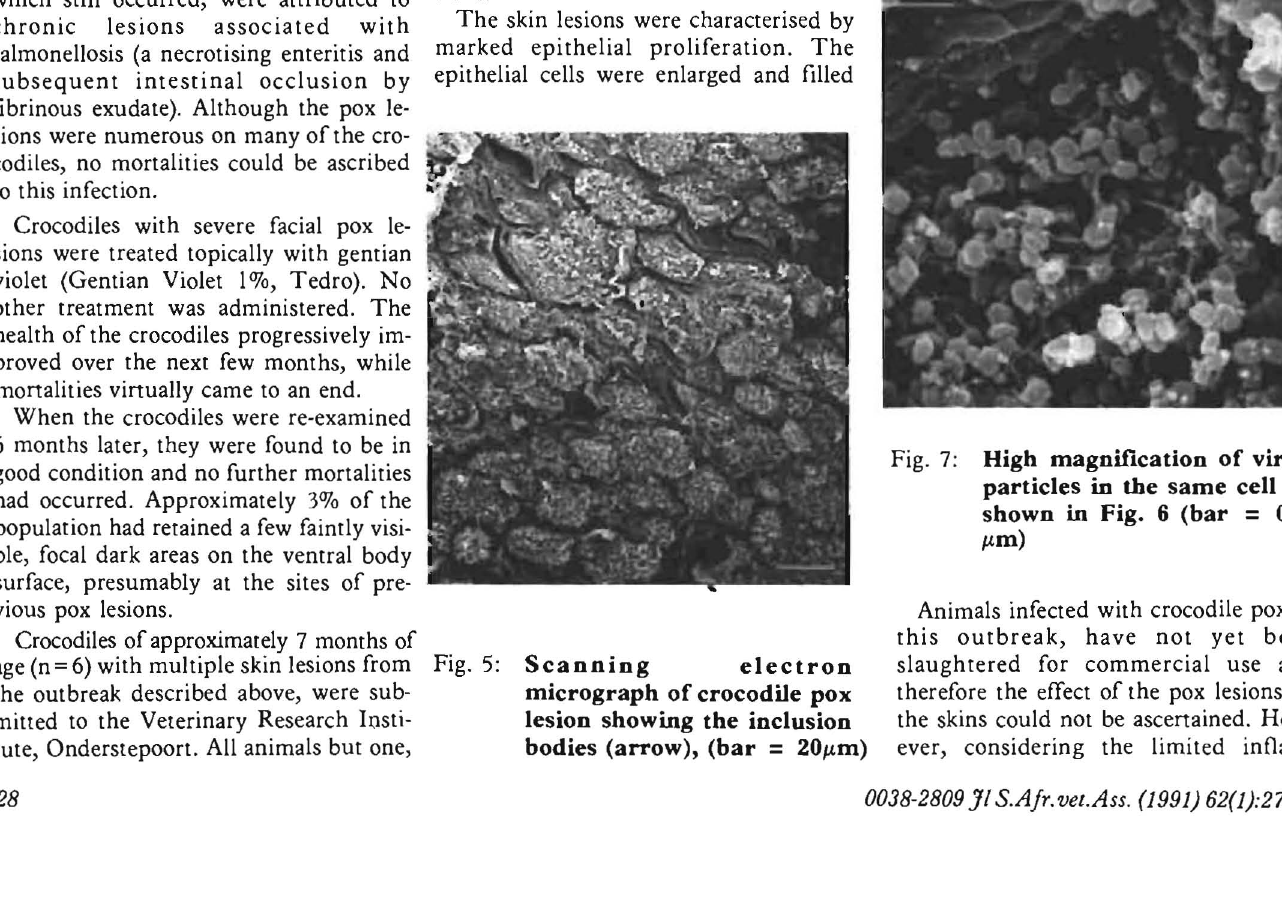
Fig. 4: Crocodile pox lesion. Note the inclusions in epidermal cells and mild perivascular inflammatory reaction (ar row) HE X 100